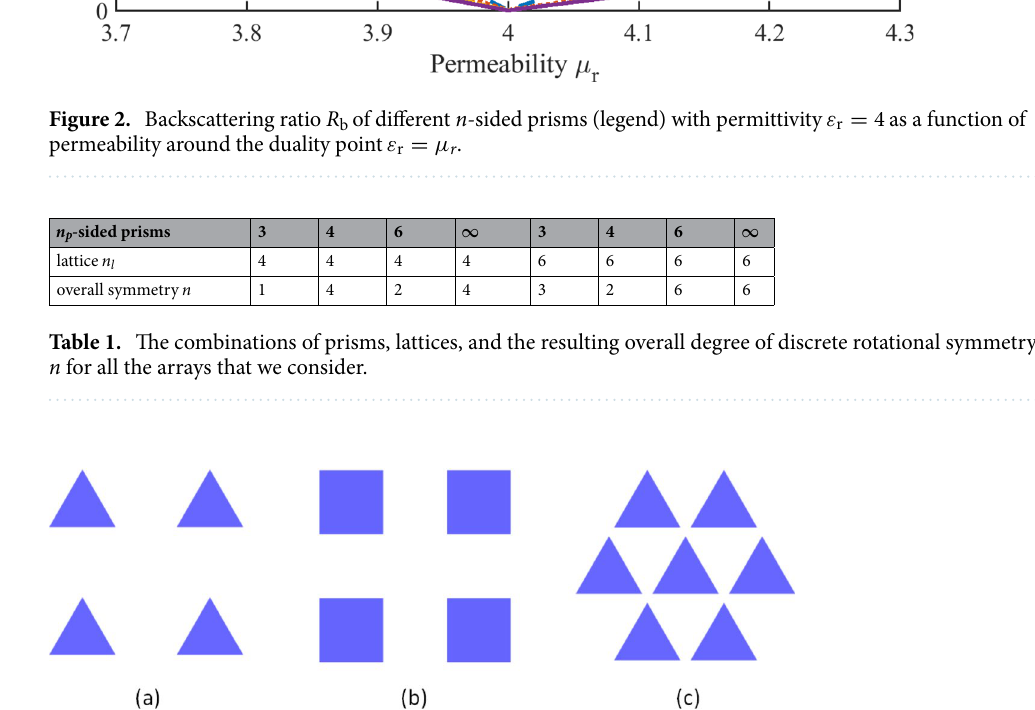
3 ) arranged in a square lattice ( n 4 ) will not be mapped l = = 1 ), while ( b ) an array = 4 ) is symmetric under rotations by multiples of 90 ◦ l = 3 ) arranged in a hexagonal lattice ( n 6 ) p = l = 3 =